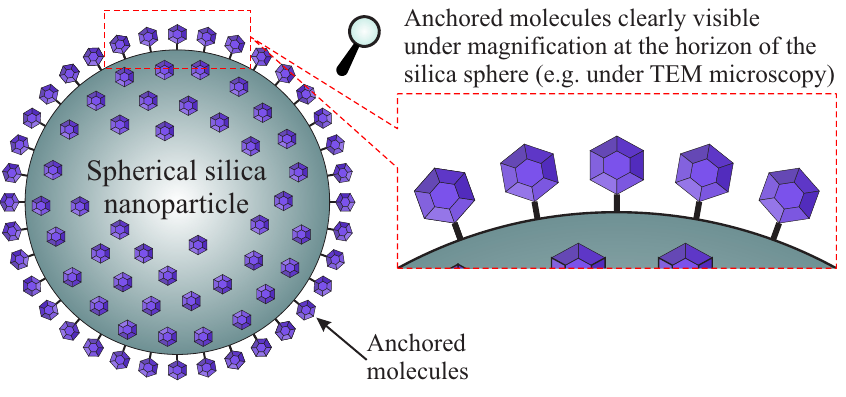
Figure 3. The concept of direct observation of separated molecules at the horizon of spherical silica